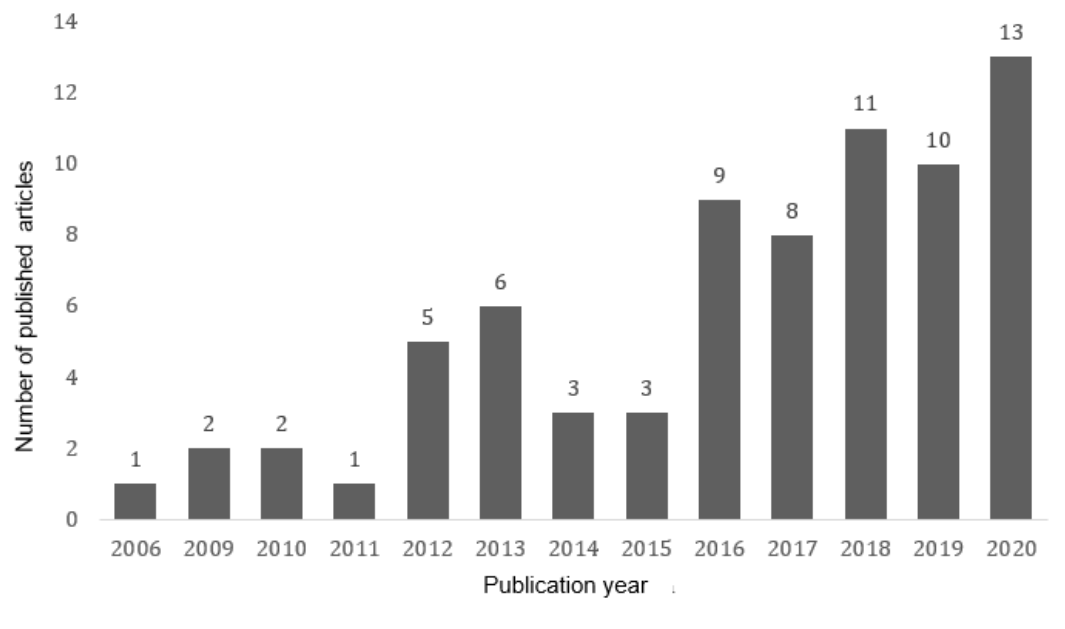
Figure 2. Number of publications that include the BES instrument over time.